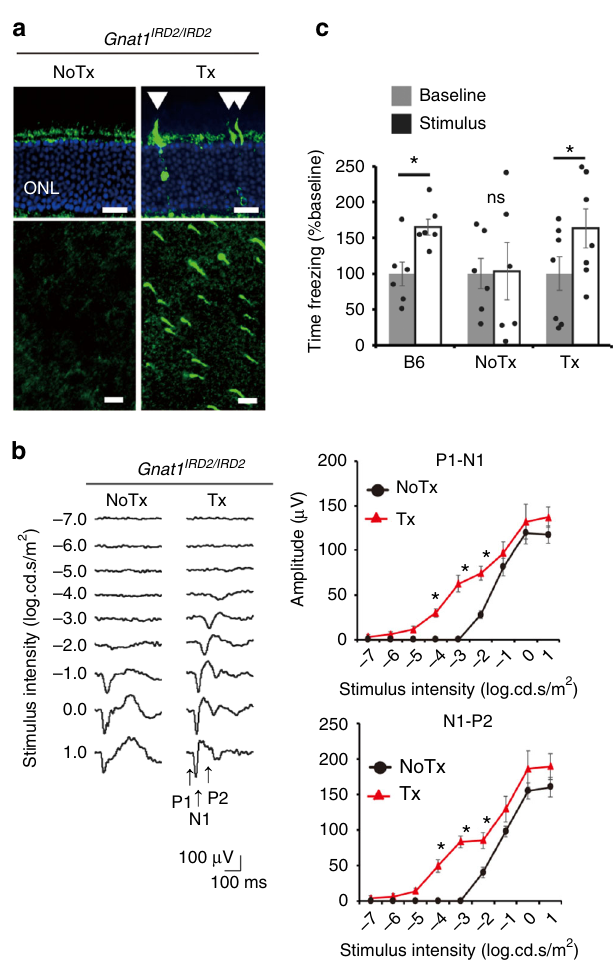
Fig. 4 In vivo mutation replacement genome editing in a mouse model of retinal degeneration. a GNAT1-positive photoreceptors (arrowhead) following treatment of Gnat1 IRD2/IRD2 mice shown in a retinal section (top) and a fl atmount (bottom). Scale bar: 20 µ m. b fVEPs recorded from contralateral visual cortices in treated and untreated eyes of the same mice. ( N = 7). c Fear conditioning test, showing freezing time before (Baseline) and during (Stimulus) presentation of fear-conditioned light cue. Treated (Tx, N = 7) and untreated (NoTx, N = 6) Gnat1 IRD2/IRD2 mice and CL57B6 mice (B6, N = 6). Data represent the mean ± S.E.M.; * P < 0.05 (Student ’ s t - test); ONL, outer nuclear layer. ns, not signi fi cant. Source data are provided as a Source Data fi